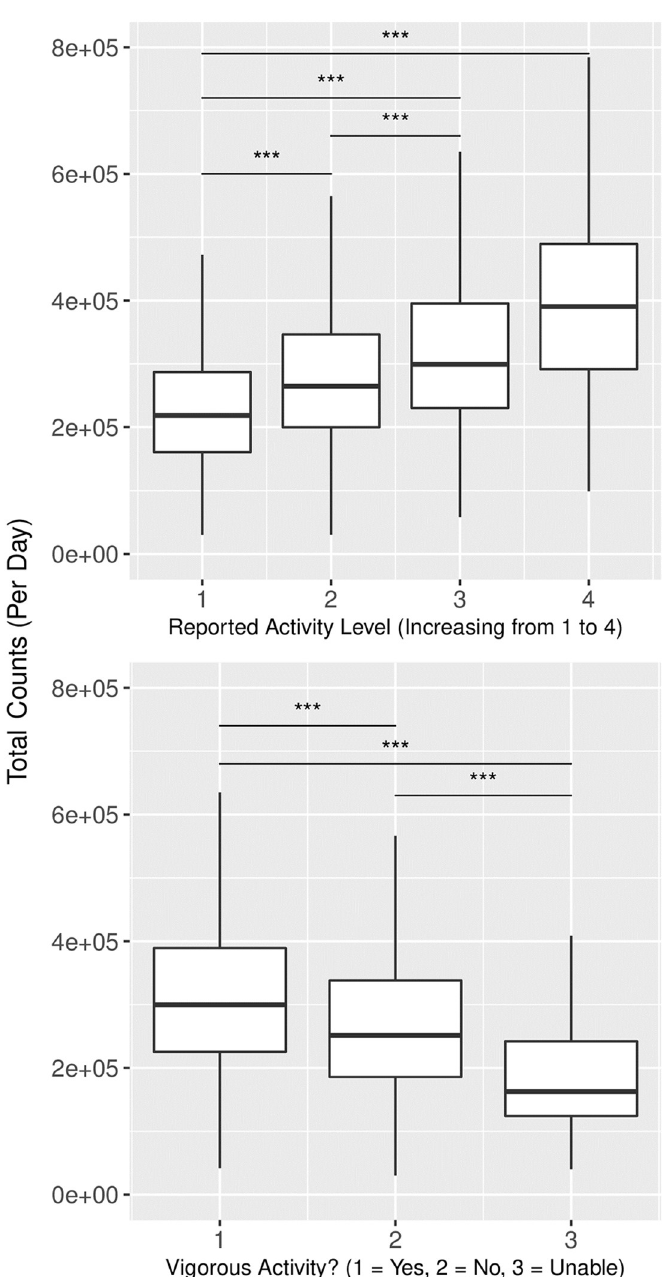
Fig 1. Validation of physical activity questionnaire. Physical activity questionnaire data (PAQ180 on left and PAD200 on right) displayed a significant relationship to accelerometry data indicating that self-reported answers were reflective of objectively measured activity levels. ��� denotes p <